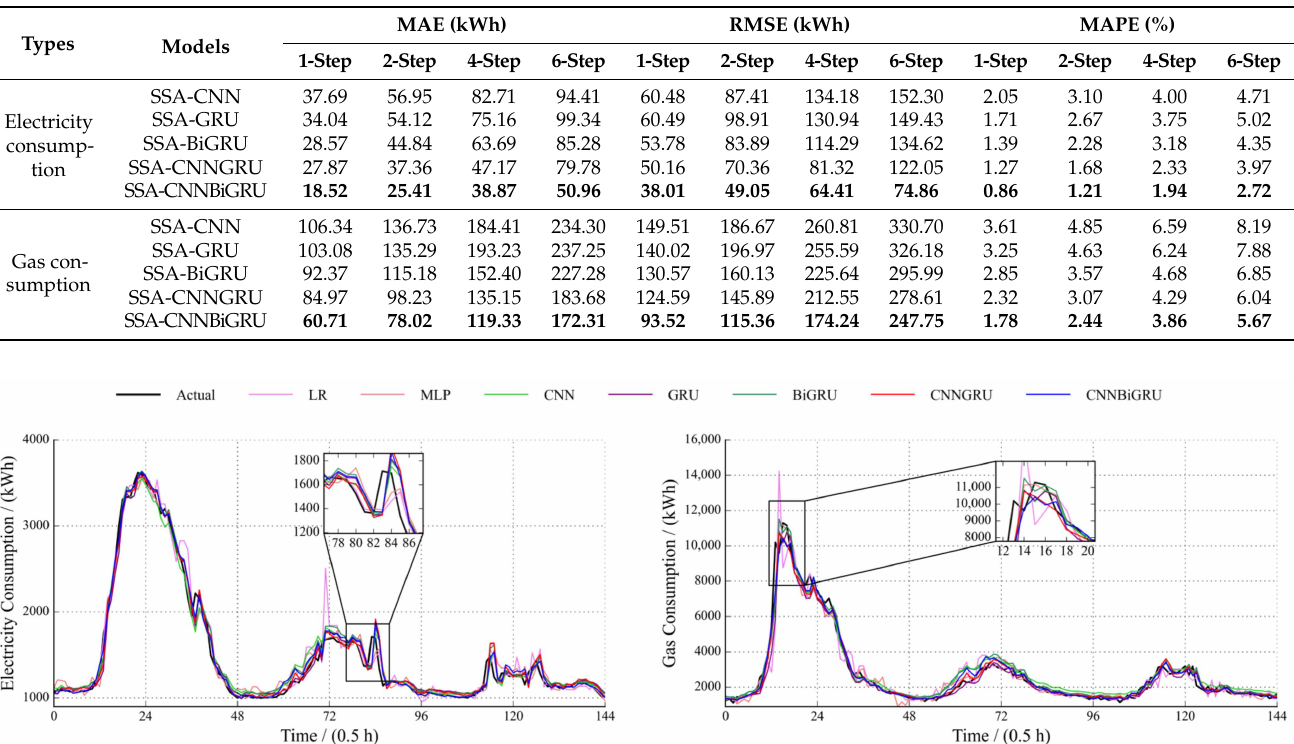
Figure 7. Comparison of one-step ahead direct forecast results of seven